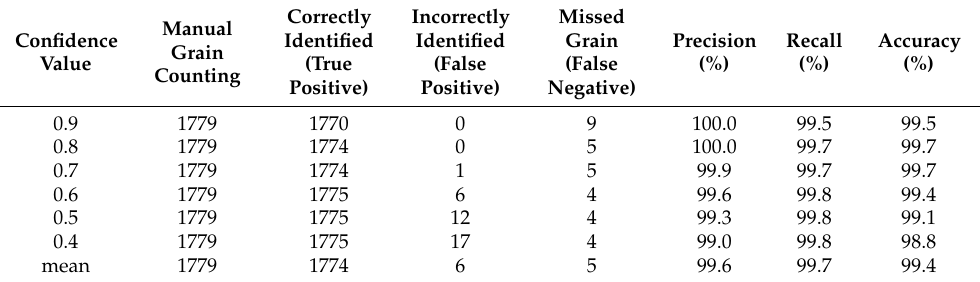
Table 3. Precision and recall from grain detection model using testing set images at